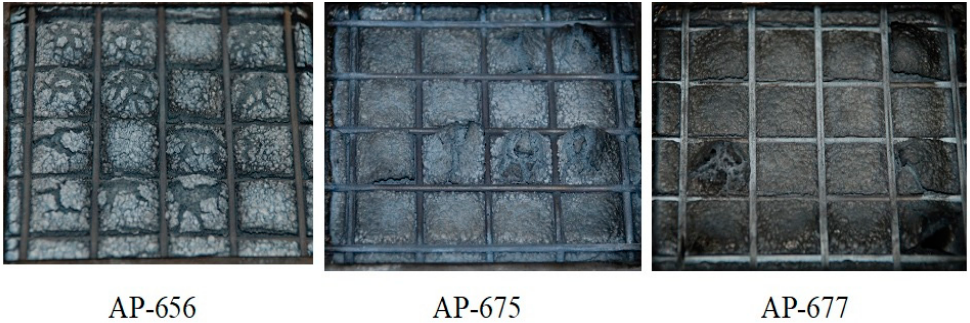
Figure 10. Heat release rate curves of AP ‐ 656, AP ‐ 675 and AP ‐ 677 as a function of burning time.